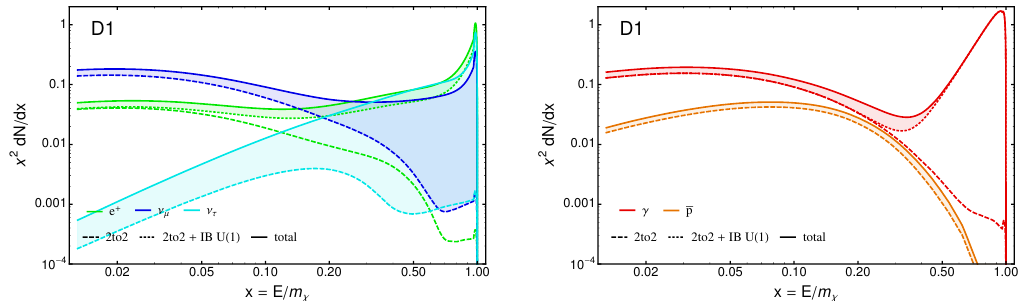
Figure 11 . Spectral energy distribution of a model where all sleptons are degenerate (D1 in table 6). In the left panel , we display leptonic (cid:12)nal states e (cid:6) , (cid:23) (cid:22) , and (cid:23) (cid:28) (green, blue and cyan line respectively) and, in the right panel photon (red) and antiproton (orange) spectra. Solid lines indicate the total (NWA-corrected two-body plus three-body) contribution, the dashed lines the two- body result. The dotted lines represent the contribution from two-body (cid:12)nal states plus that from photon bremsstrahlung alone. Shaded areas thus highlight the e(cid:11)ect of including SU(2) corrections.